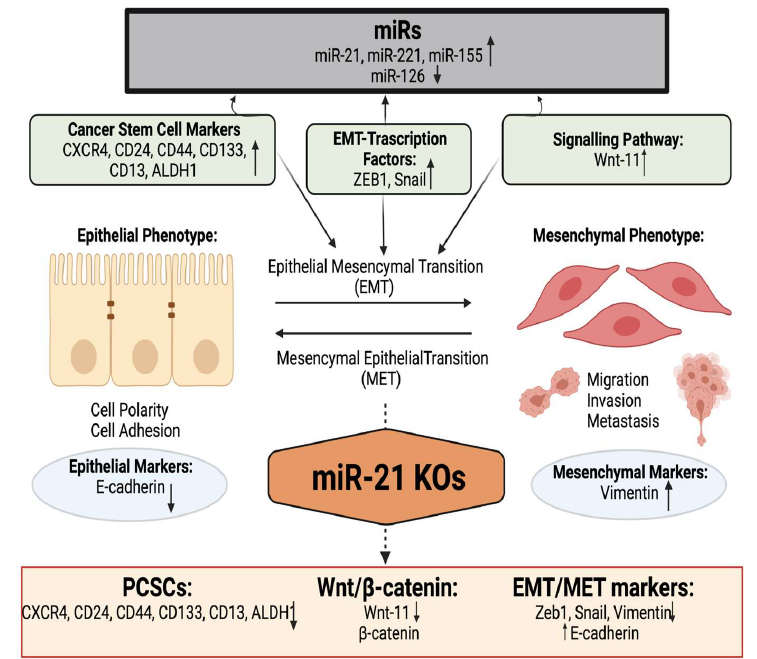
Figure 8. Overview of the involvement of miR-21 in cancer stemness and EMT in PDAC. According to our data, miR-21 affected cancer stemness, EMT, and the Wnt-11 pathway. Created with BioRender.com (accessed on 3 December 2021).